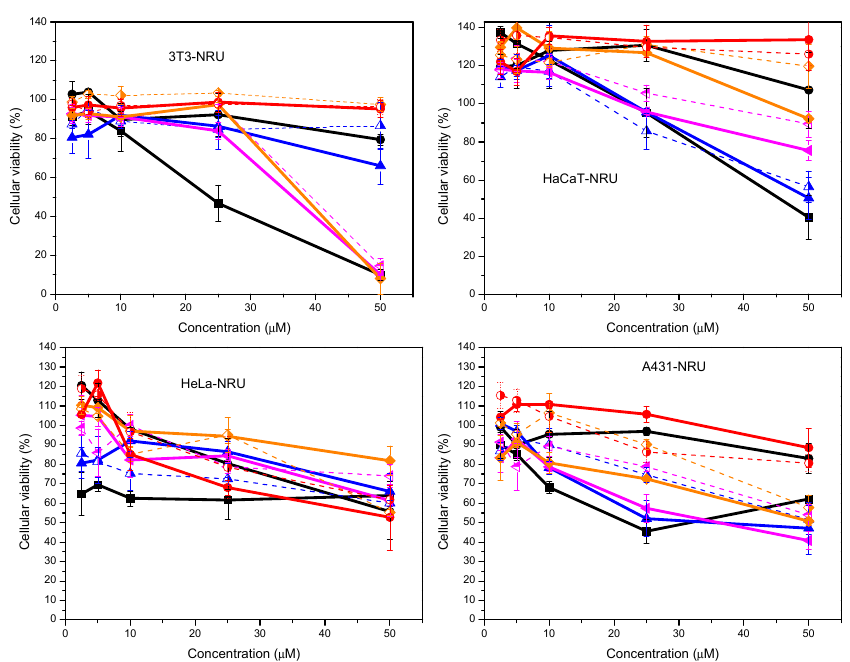
Figure 9. Cellular viability (%) as a function of concentration for di ff erent cellular lines using the NRU